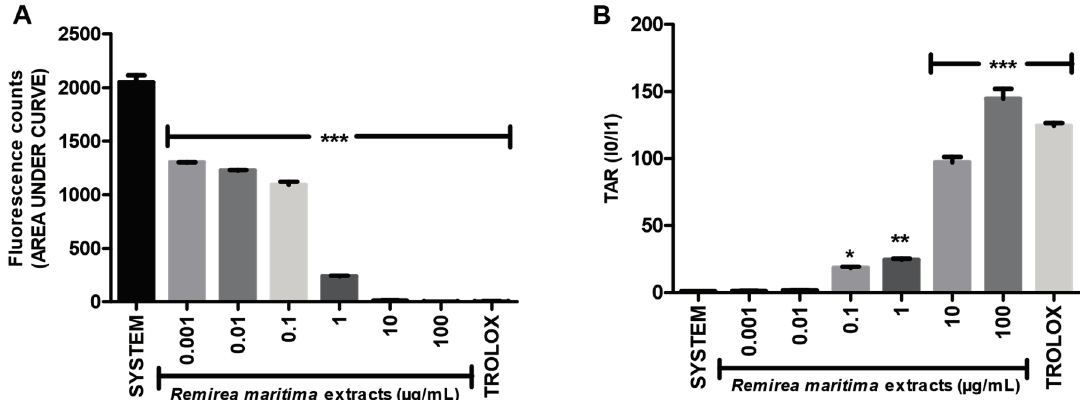
Figure 1. ( A ) Total reactive antioxidant potential (TRAP) assay; ( B ) Calculated total antioxidant reactivity (TAR) values. Trolox ® (75 µg/mL) was used as standard antioxidant. Bars represent mean ± SEM. * p < 0.05, ** p < 0.01, *** p < 0.001 (1-way